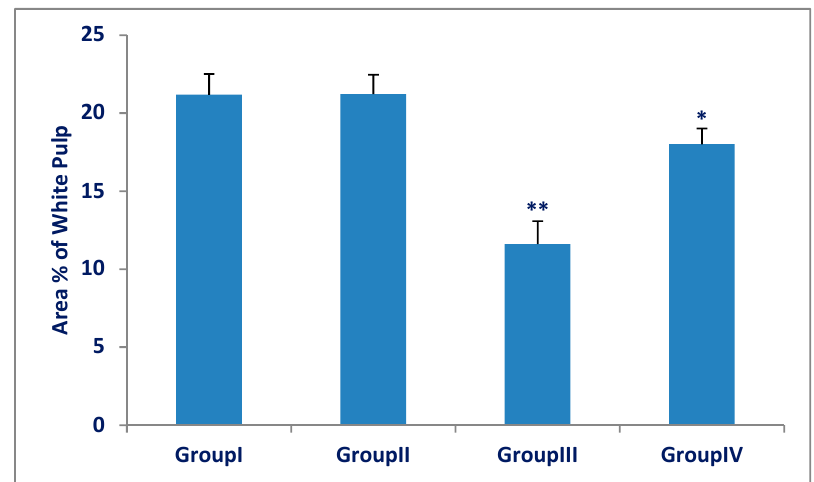
Figure 3. Area percentage of the white pulp of the spleen in group (III) (Olanzapine group) was significantly decreased as compared to group (I) (control group). A significant increase in group (IV) (Olanzapine and vitamin C) as compared to group (III).The differences in area percentage of white pulp between group (I) and group (II) were not significant ( p > 0.05). Results are expressed as mean ± SD and the level of significance was set for p -values less than 0.05. **: significant decrease, group (III) versus group (I) ( p < 0.001). *: significant increase, group (IV) versus group (III) ( p < 0.001).